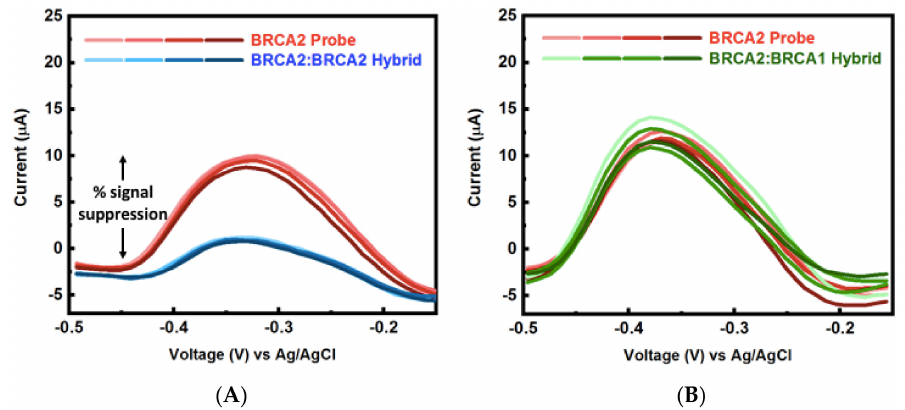
Figure A7. Example SWV raw data for BRCA2 probe and ( A ) BRCA2:BRCA2 hybrid perfect-match, Figure 5—Multiplexed detection of breast cancer-related